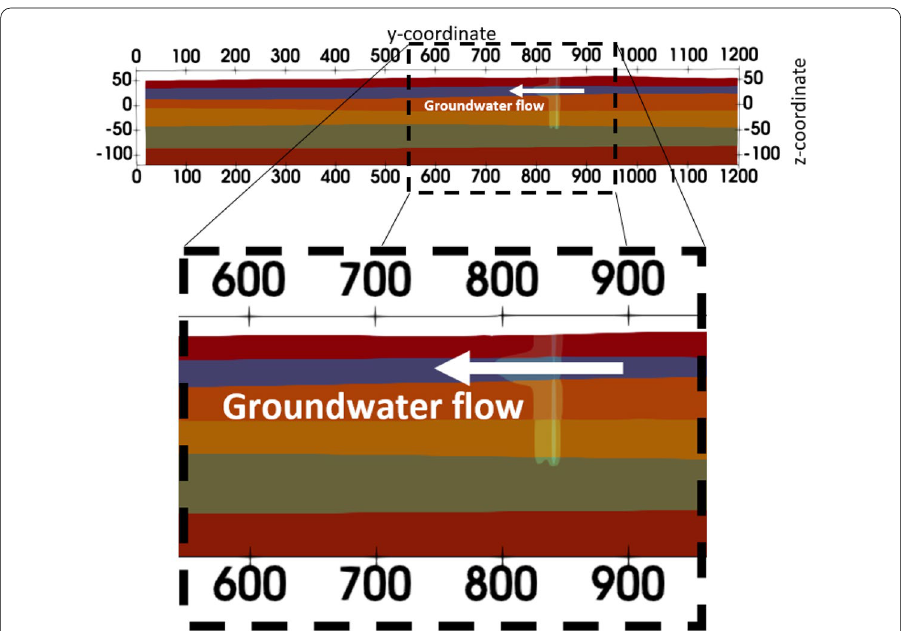
Fig. 3 Hydraulic group layers and groundwater flow in the